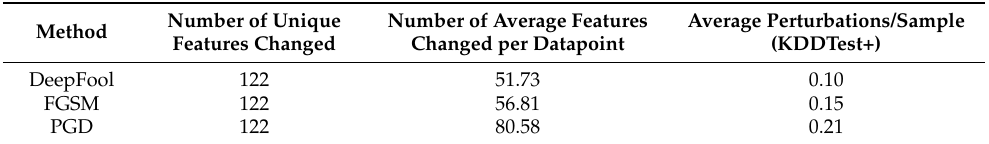
Table 5. Statistics of adversarial test sample